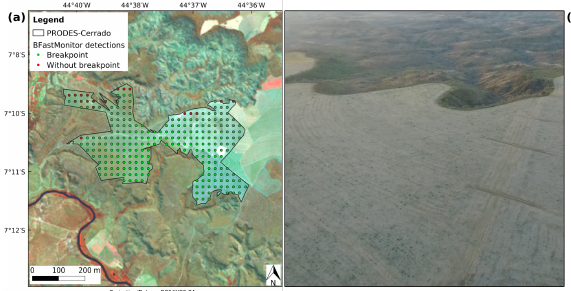
Figure 1. (a) The BFastMonitor result on a deforestation polygon of PRODES-Cerrado, in the municipality of Benedito Leite-TO. (b) Aerial image of the deforested area, obtained during the field validation in August 2018.